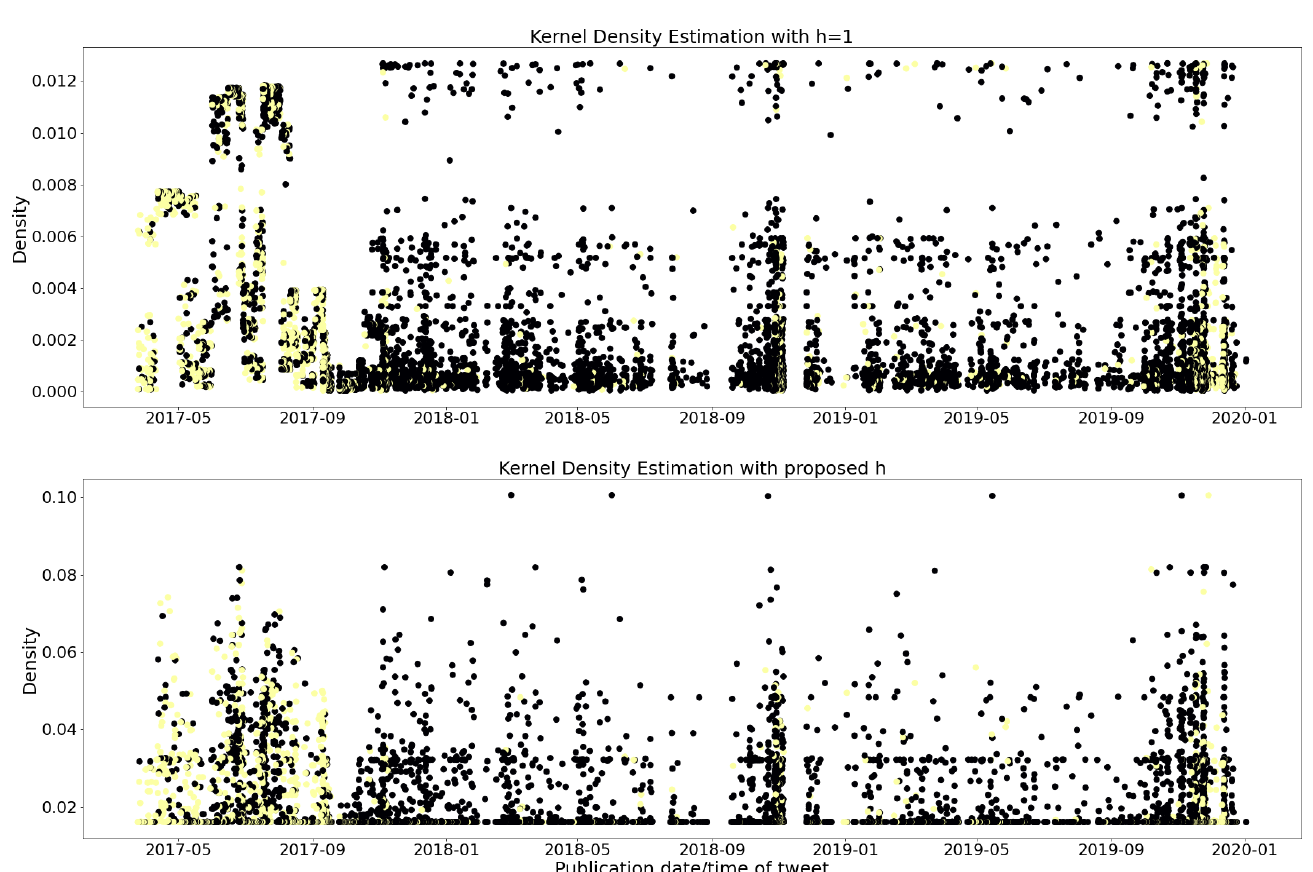
Figure 3. Kernel Density estimation on the MediaEval dataset. Estimation with bandwidth h = 1 on the first plot and Sheather and Jones on the second. The horizontal axis shows the time when tweets were posted and the vertical axis the density estimation. Yellow dots represents relevant tweets, while black the non-relevant